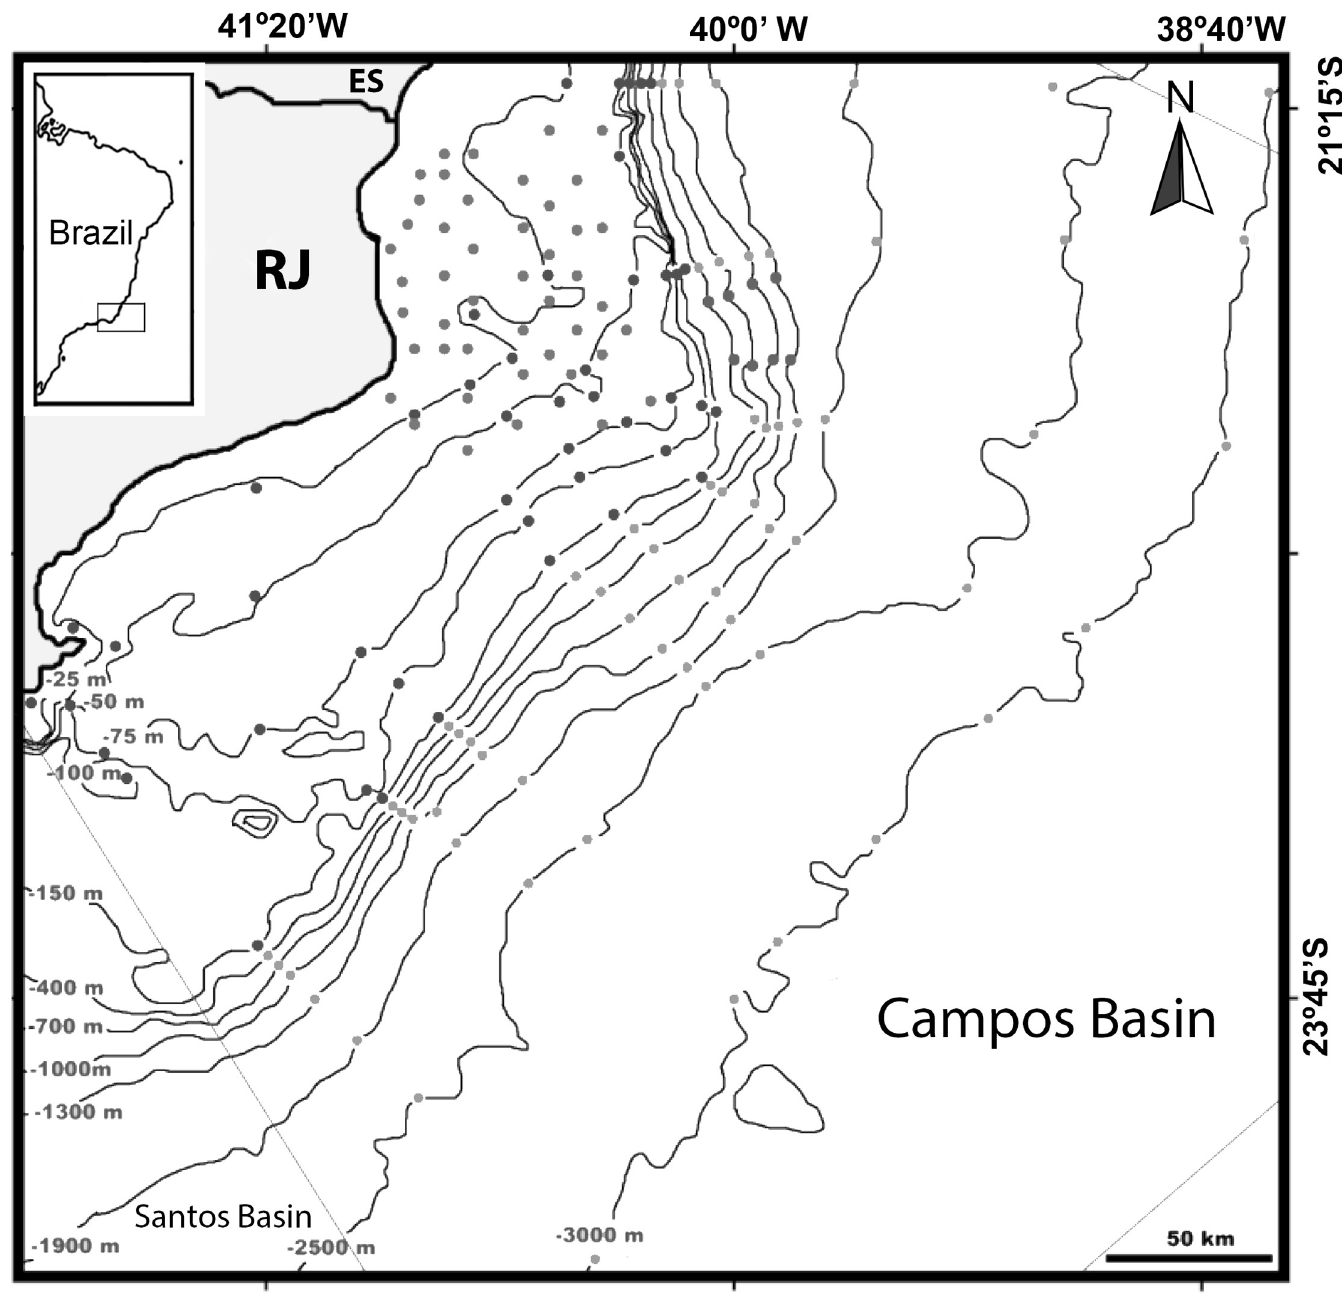
Fig 1. Study area, Campos Basin, Brazil. Sampling stations are represented by coloured